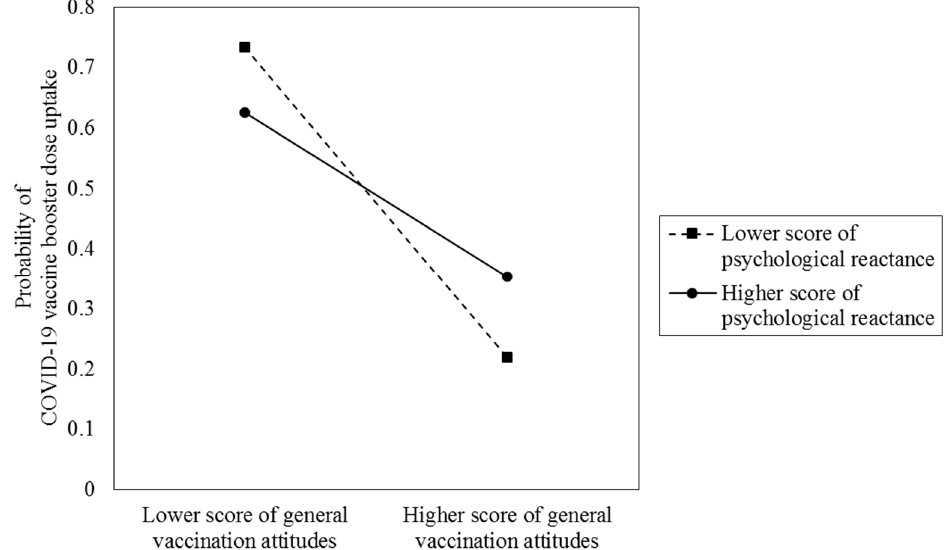
Figure 2. The moderating role of psychological reactance on the effects of negative attitudes towards vaccination in general on uptake of a booster dose ( n = 264).